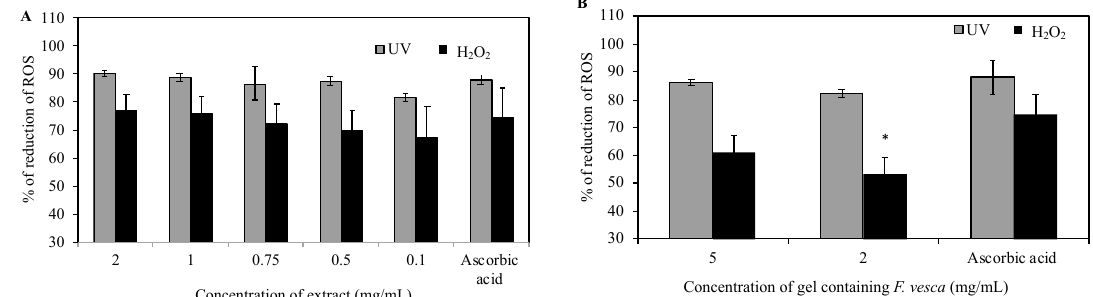
Figure 3. ( A ) Effect of F. vesca extract and ( B ) F. vesca- based hydrogel on the percentage of reduction of ROS production in HaCaT cell cultures in the presence of H 2 O 2 during 1 h, or when the cells are UVB-irradiated for 15 min. Ascorbic acid (AA) was used as a positive control. The statistical comparison with the positive control is also shown (* p < 0.05) (Mean ± SD, n = 6).